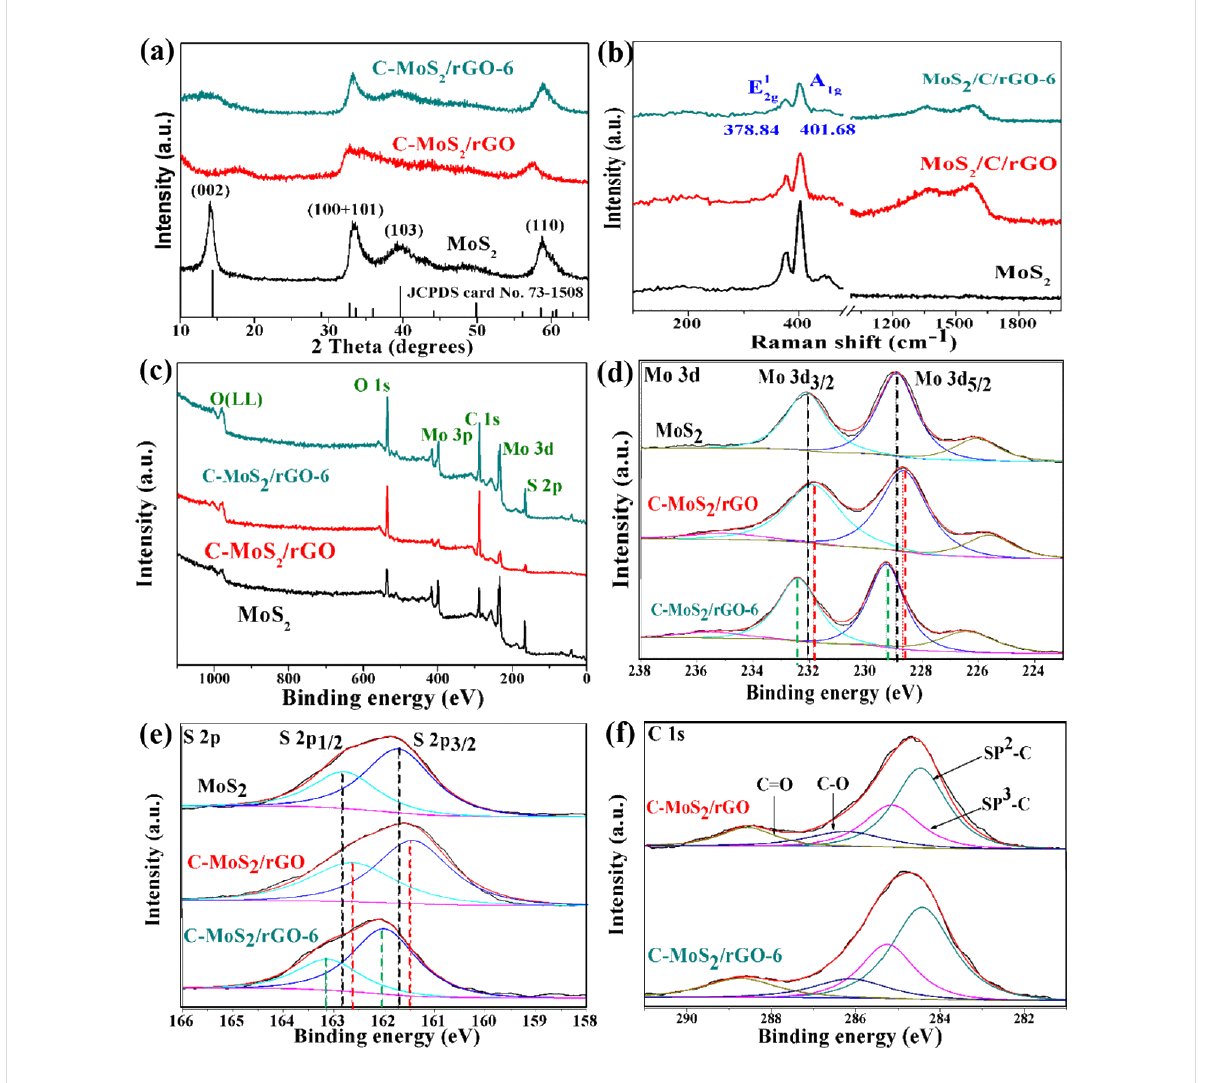
Figure 4: (a) XRD patterns, (b) Raman spectra, (c) full scan XPS spectra and high-resolution XPS spectra of (d) Mo 3d and (e) S 3d of pristine MoS 2 , C-MoS 2 /rGO and C-MoS 2 /rGO-6 composites, and (f) high-resolution XPS spectra of C 1s C-MoS 2 /rGO and C-MoS 2 /rGO-6 composites, respectively.